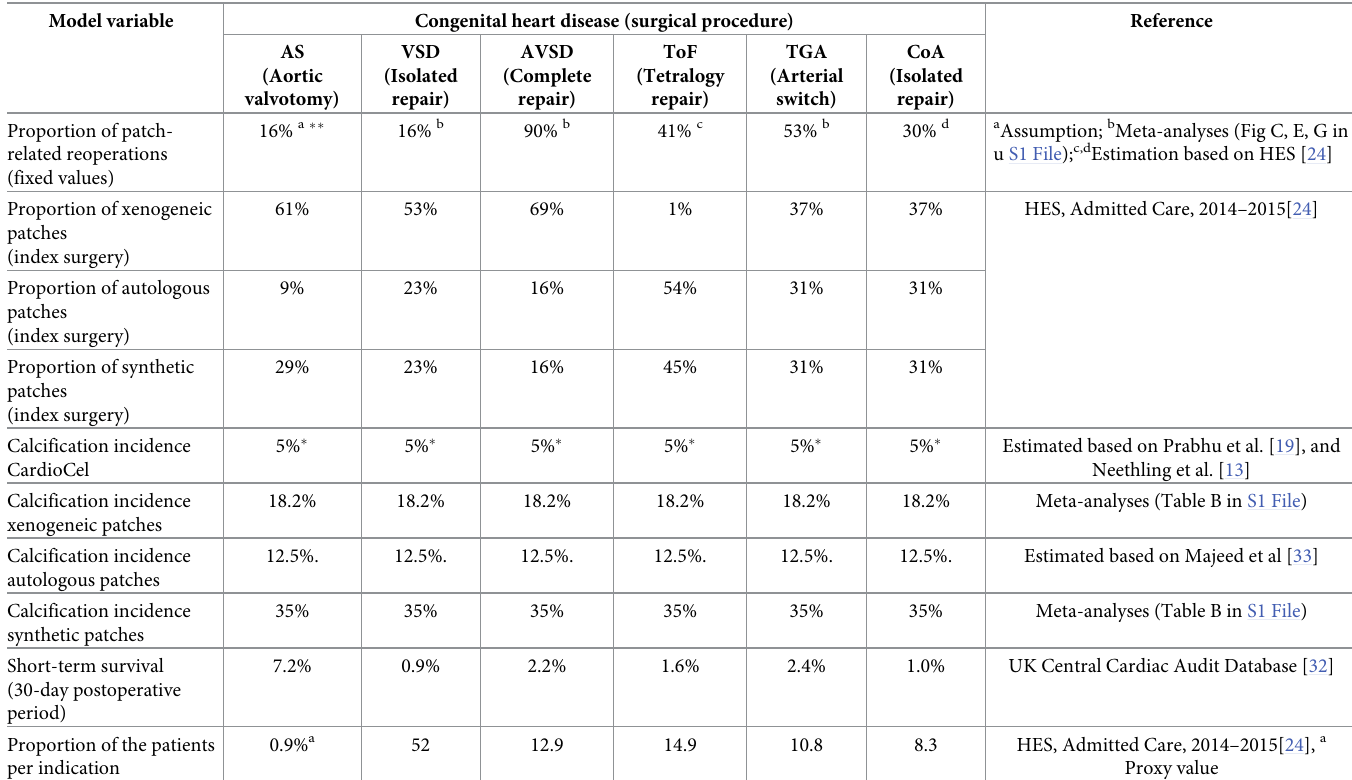
Table 4. Clinical parameters.